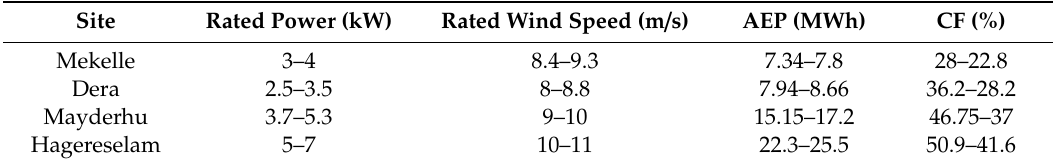
Table 3. Proposed rated power and corresponding parameters of the four sites.